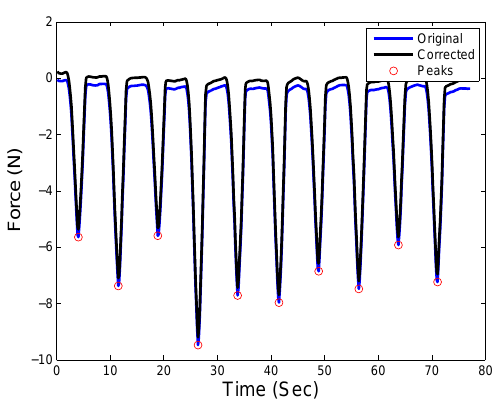
Figure 15. Force correction of the ’hard inclusion 10 mm beneath the surface’ case. The blue curve is the original measured force from the sensor, and the black curve shows the corrected force by using the force compensation approach. Peak forces are highlighted with red circles.